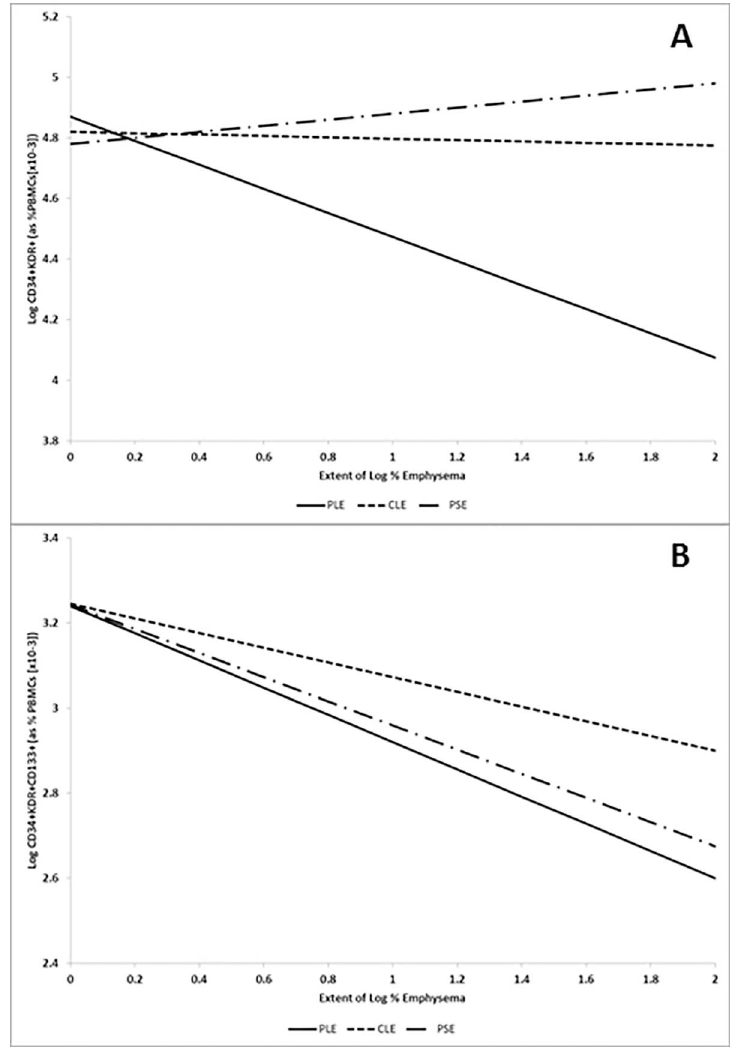
Fig 2. Representation of EPCs levels with extent of emphysema on log-log scale by emphysema subtype. Lines represent modellingresults after adjustmentfor age, gender, race/ethnicity, cohort, smoking status, pack-years, educational attainment, body mass index, height, diabetes mellitus, hypertension, oxygen saturation, white blood cell count, sleep apnea, HDL, and statin use. Panel A: CD34+KDR+. Panel B: CD34 +KDR+CD133+.PLE is panlobularemphysema, CLE is centrilobularemphysema and PSE is paraseptal